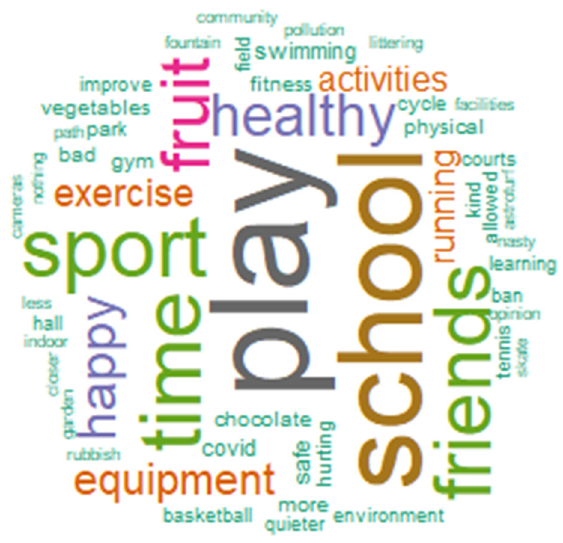
Figure 1. Frequently coded